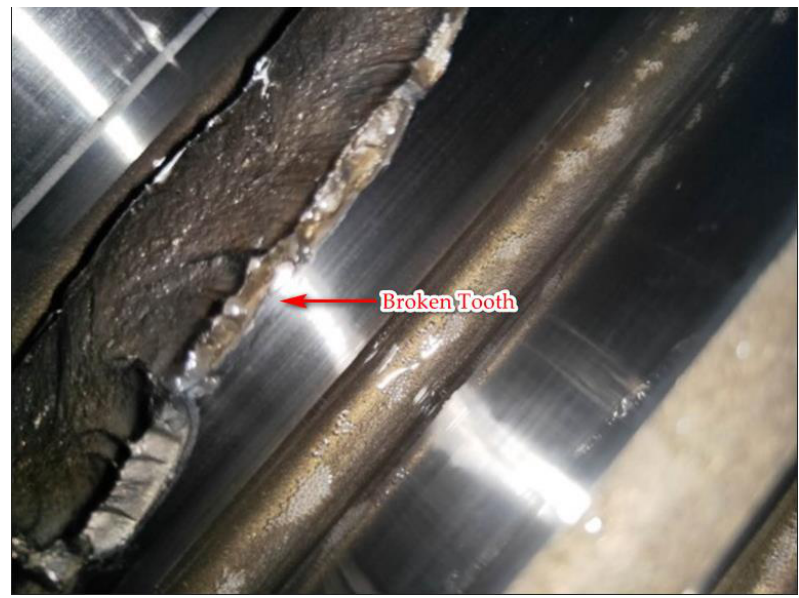
Figure 14. Gearbox med-speed gear broken tooth fault in wind turbine A.